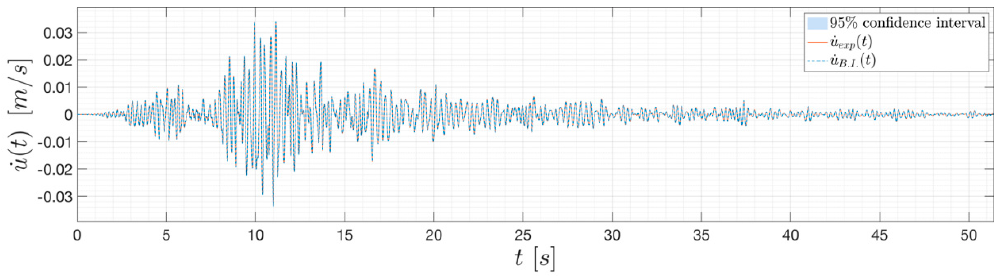
Figure 11. Velocity response prediction of the BWBN model for the case study.